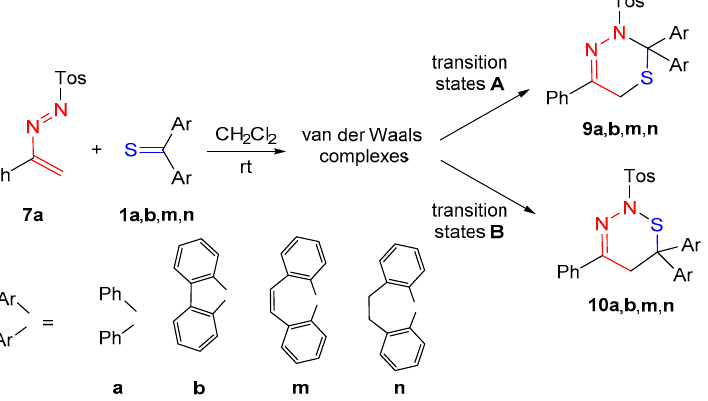
Figure 4. Transition states B of cycloadditions of azoalkene 7a with thiobenzophenone ( 1a ) ( left side) or thiocyclobutanone derivative 1i ( right side) hypothetically leading to 1,2,3-thiadiazine derivative 10a or 10iB, respectively. . Figure 5. Transition states of the two-step cycloaddition of azoalkene 7a with 3-thioxocyclobuta- none derivative 1i ; left side: TS A1 leading to zwitterion Z and TS A2 for the cyclization of Z lead- ing to 1,3,4-thiadiazine derivative 9q .